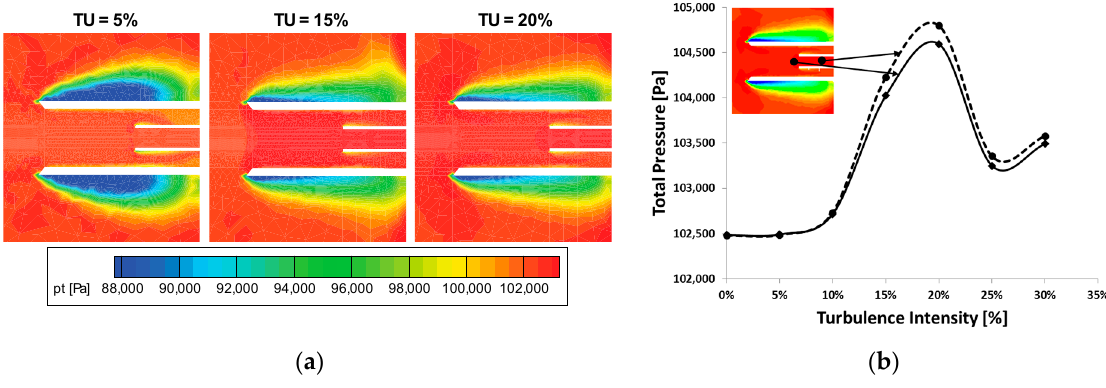
Figure 9. Total pressure from numerical investigation of a Kielhead for different turbulence intensities at the inlet ( a ) 2D plots of the Kielhead ross ‐ section and ( b ) total pressure inside the Kielhead for different turbulence intensities. TU: turbulence intensity.